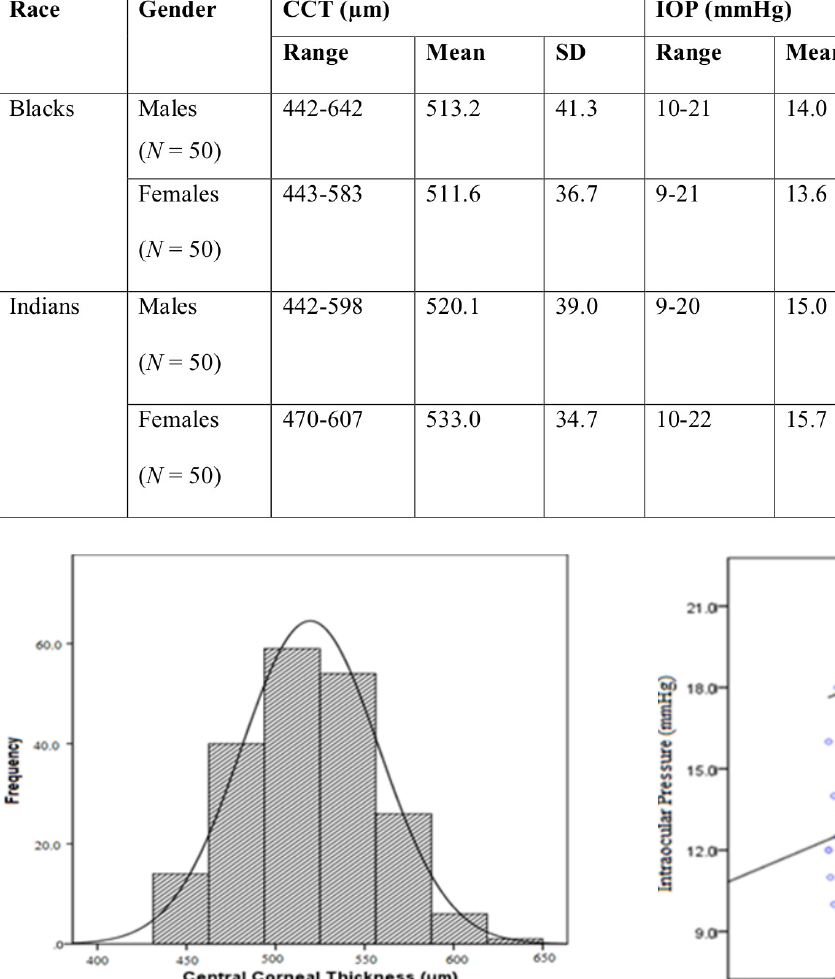
Figure 1: Histograms showing the distribution of CCT of the subjects ( N = 200). The mean CCT of the population was 519.5 μm.